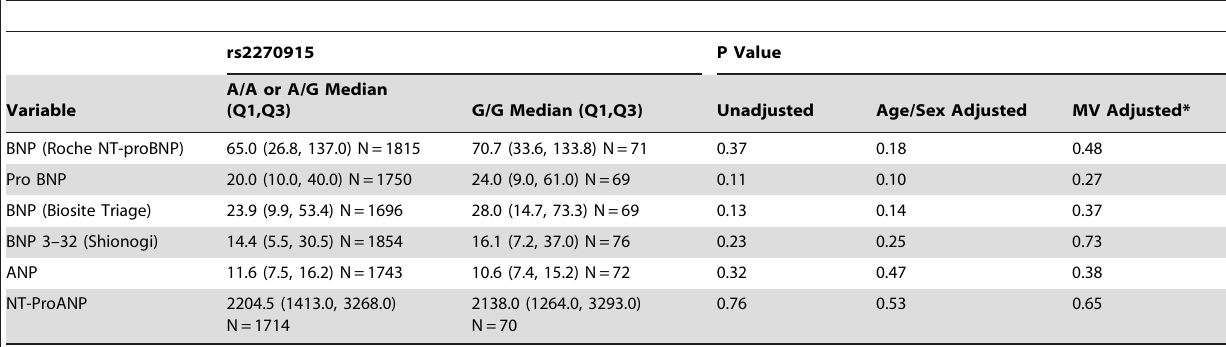
Table 4. Circulating Natriuretic Peptide Level in the Study Population According to the rs2270915